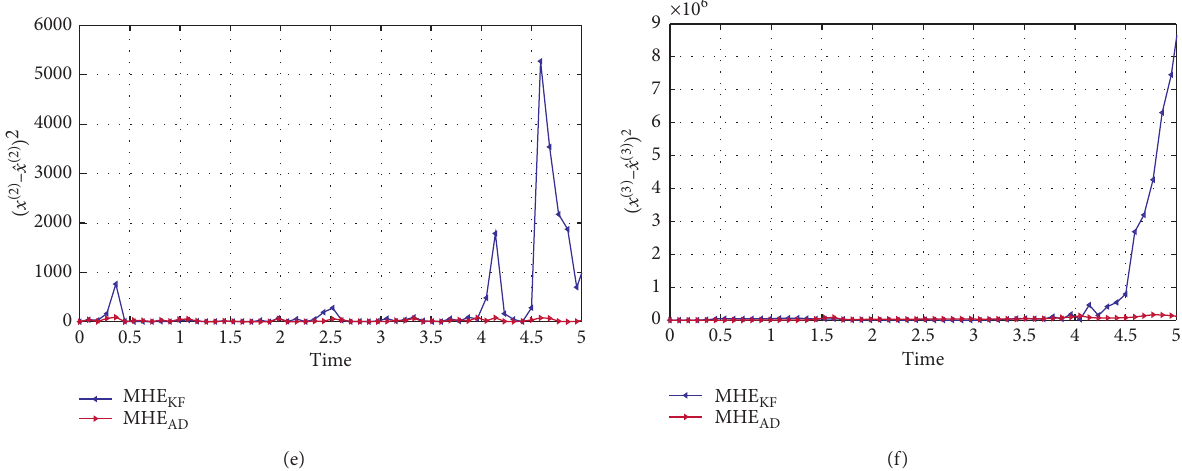
Figure 6: Comparison of estimators for model (22) with horizon length N � 10. (a) Estimation of x ( 2 ) . (b) Estimation of x ( 2 ) . (c) Estimation of x ( 3 ) . (d) ( x ( 1 ) − 􏽢 x ( 1 ) ) 2 . (e) ( x ( 2 ) − 􏽢 x ( 2 ) ) 2 . (f) ( x ( 3 ) − 􏽢 x ( 3 ) ) 2 .